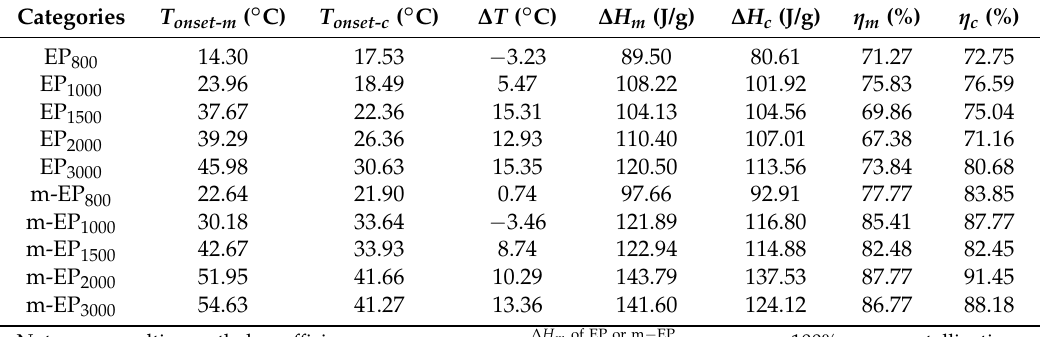
Table 5. Thermal properties of EPs and